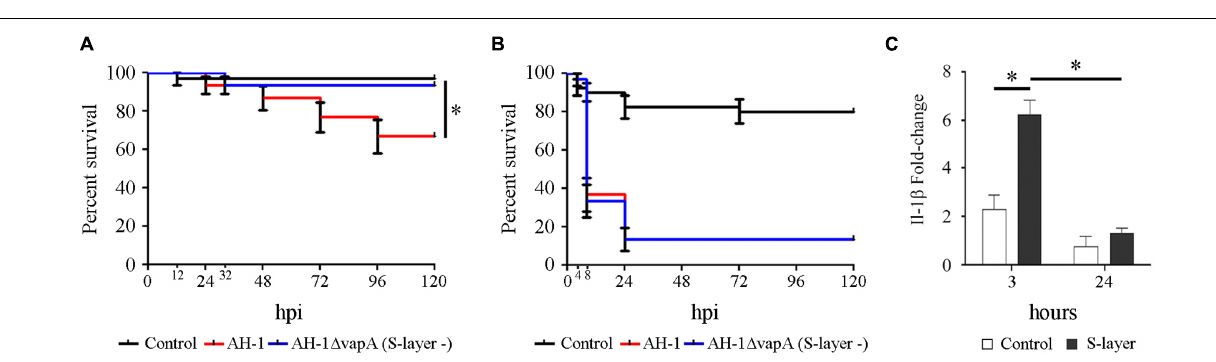
FIGURE 4 | Implications of the S-layer in the pathogenesis of A. hydrophila . (A) Kaplan–Meier survival curve of healthy (A) and injured (B) larvae infected with A. hydrophila AH-1 wild-type and the mutant AH-1 (cid:49) vapA (S-layer negative). ∗ Significant differences at P = 0.002. (C) Effects of microinjection of the purified AH-1 S-layer (100 ng) on the expression of Il-1 β at 3 and 24 h post-injection. ∗ Significant differences at p <